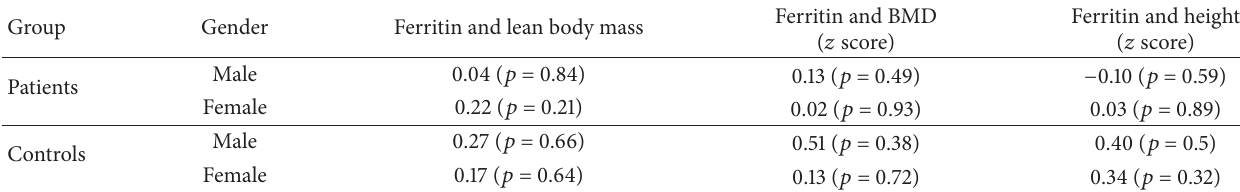
Table 4: Correlation between ferritin and lean body mass, bone mineral density 𝑧 scores, and height 𝑧 scores.